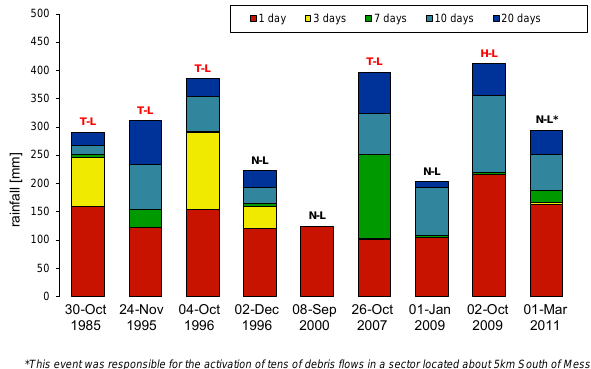
Figure 2. Bar plot showing the cumulative (1 day, 3, 7, 10 and 20 days) rainfall in mm respectively for the main nine events recorded in the Itala catchment